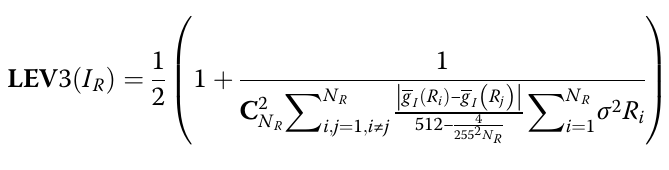
Table 3 Values of Levine and Nazif evaluation of criteria for various methods Imagery Threshold Filter Intra-region criterion